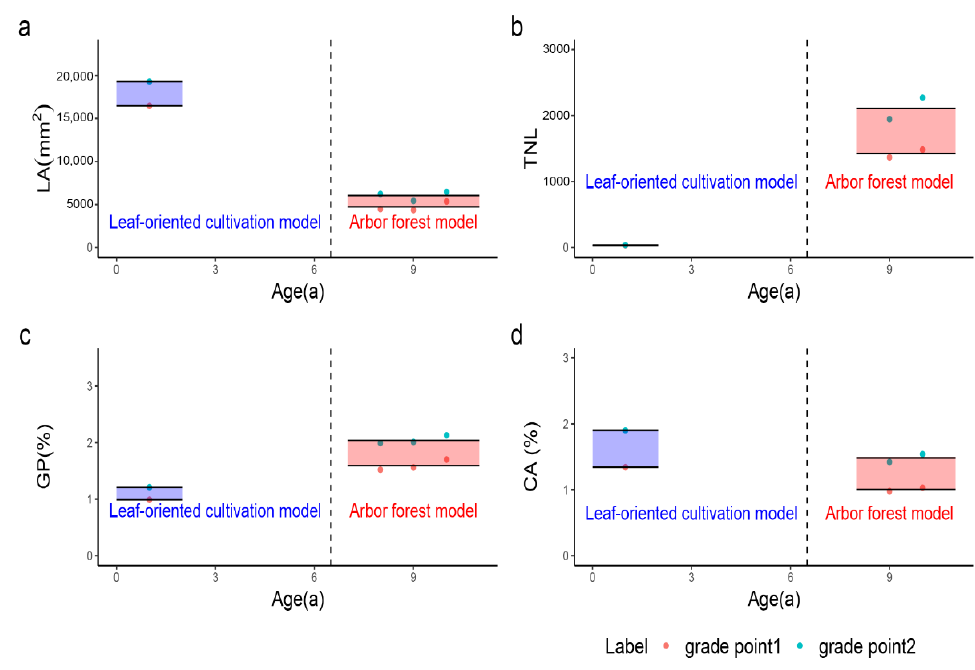
Figure 2. The classification criteria of the main evaluation indexes, including ( a ) LA, ( b ) TNL, ( c ) GP, and ( d ) CA. The black solid lines above and below the rectangle indicate the average level of grade points in each planting model. The lines at the top and bottom of the rectangle box represent the adjusted grade points. Traits were divided into three grades by the rectangle box: the 1st grade (the part below the rectangle), the 2nd grade (the part within the rectangle), and the 3rd grade (the part above the rectangle). The dashed line represents the boundary between the Leaf-oriented cultivation model and Arbor forest